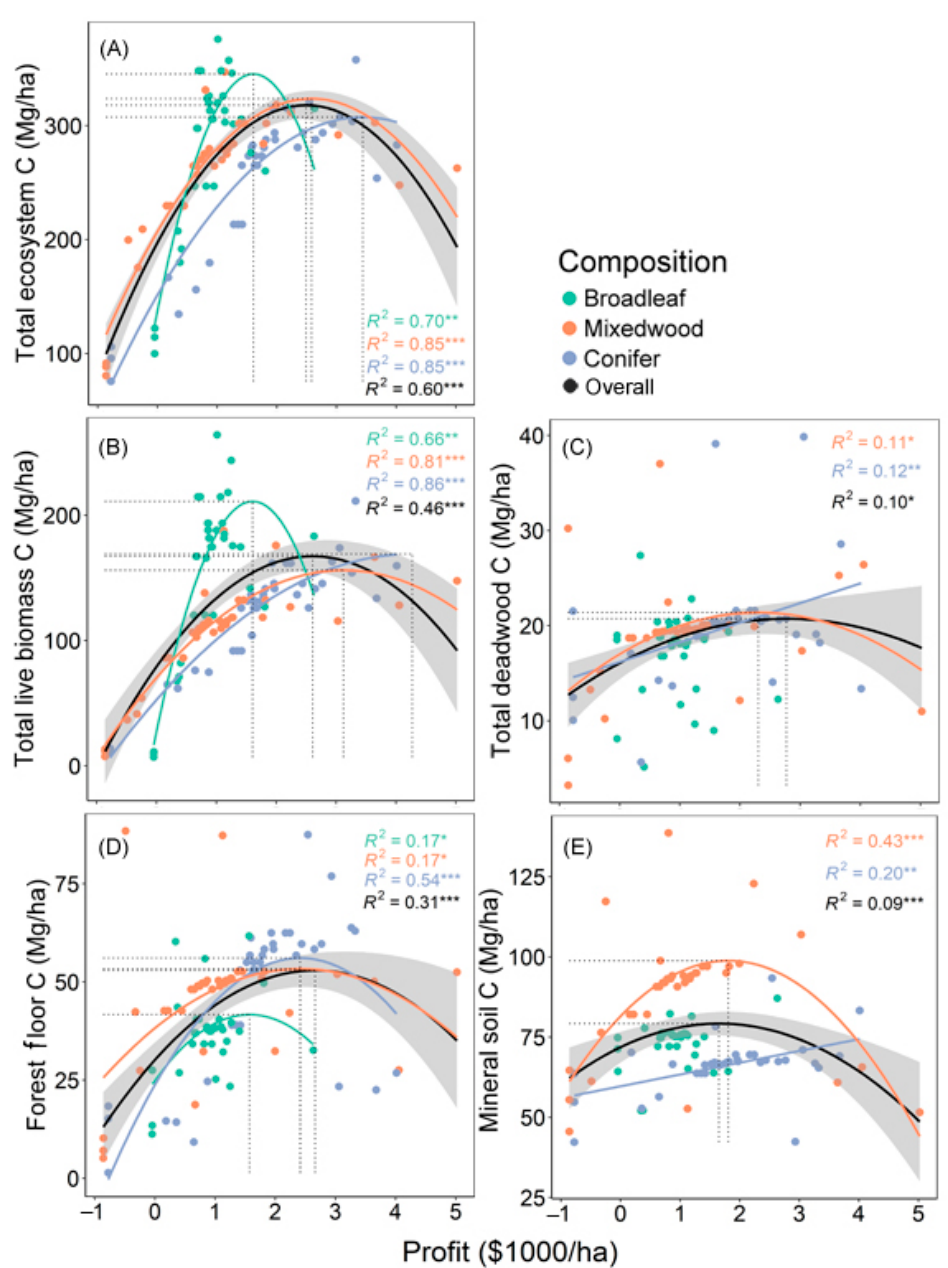
Figure 1. Trends in ( A ) total ecosystem C, ( B ) total live biomass C, ( C ) total deadwood C, ( D ) forest floor C and ( E ) mineral soil C with profit and in relation to overstorey compositions. Adjusted R 2 values are based on linear or polynomial regressions. Black lines with the shaded region are estimated mean and 95% confidence intervals. Significant differences ( α = 0.05). Significant codes ( p -value): 0 ‘***’, 0.001 ‘**’, 0.01 ‘*’.